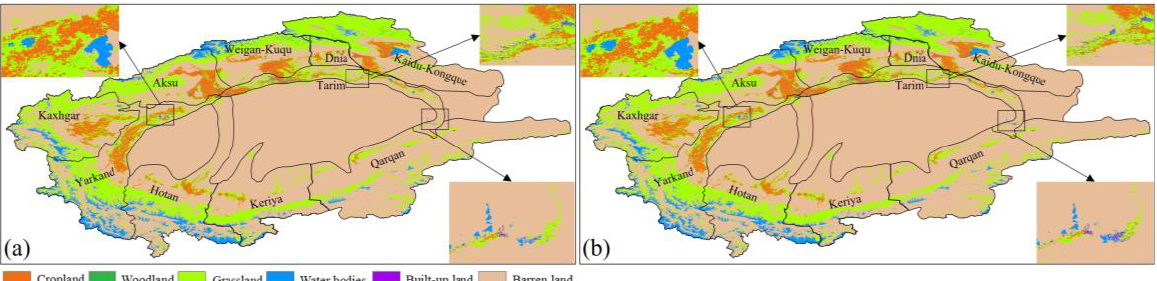
Figure 9. Map of simulated and actual land use change in the Tarim River Basin in 2015. ( a ): Actual result ( b ): Simulation result.